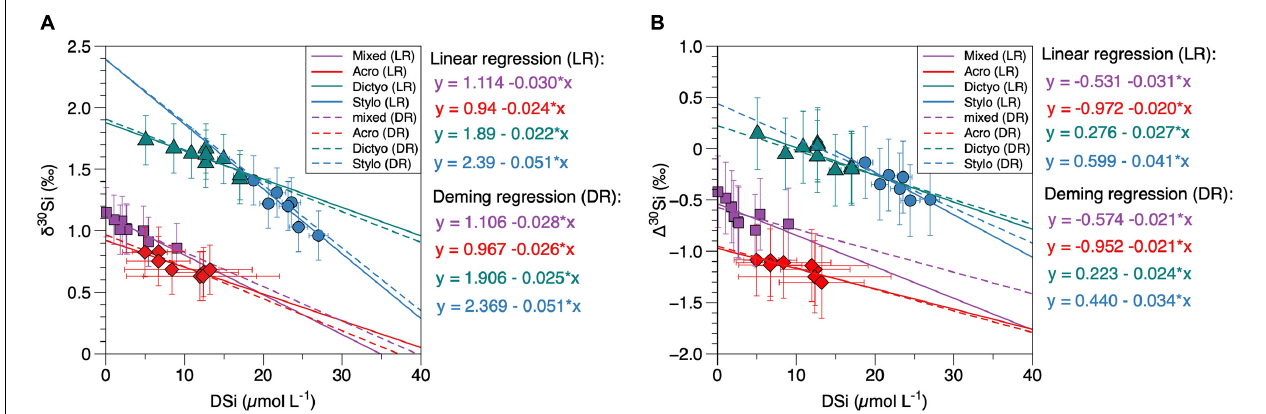
FIGURE 4 | (A,B) δ 30 Si and (cid:49) 30 Si values of radiolarian groups ( δ 30 Si rad ) compared to DSi concentrations (same as marked in bold in Figures 3E–H and in Table 3 ). Colors refer to different radiolarian taxa (red: A. murrayana , green: Dictyocoryne sp., blue: Stylochlamydium sp., purple: mixed radiolaria). Colored lines indicate linear regressions for each group, dashed lines indicate the Deming regressions. Error bars indicate the external reproducibility in (A) , in (B) , the propagated error is given for values on the y-axis. For better readability, all statistical values for regressions are given in Table 3